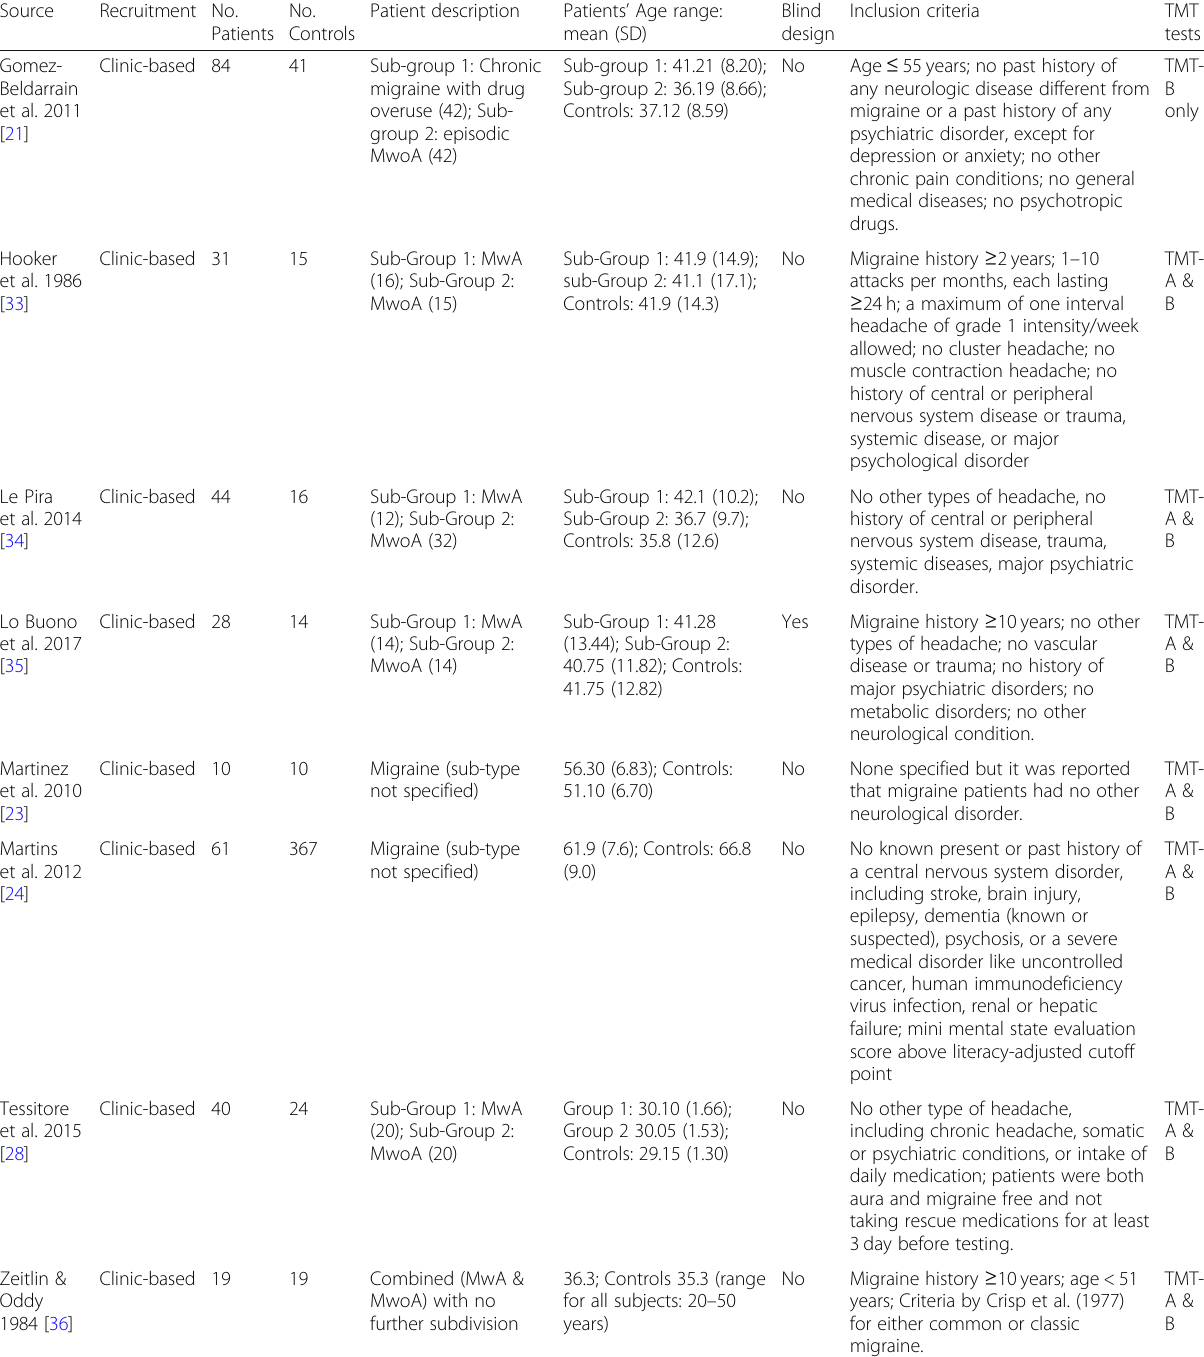
Table 1 Summary of included studies assessing performance of patients with migraine on Trail Making Test (TMT) (Continued) Source Recruitment No. No. Patient description Patients ’ Age range: Blind Inclusion criteria TMT Patients Controls mean (SD) design